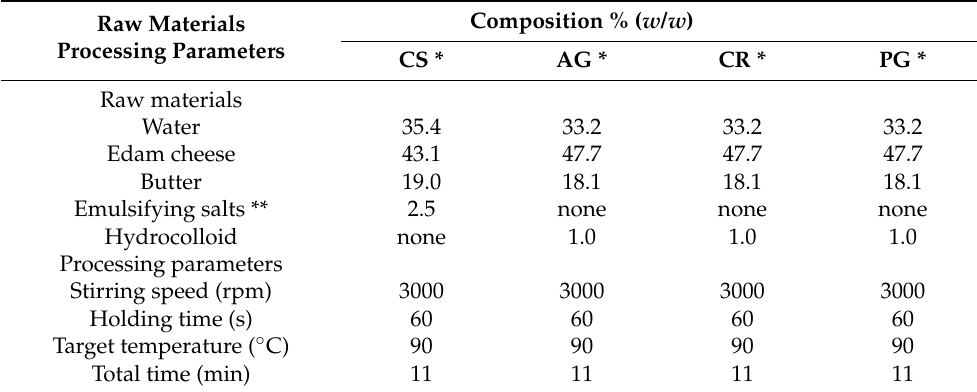
Table 1. Formulation of the raw materials and processing parameters used for the processed cheese samples ***. Raw Materials Processing Parameters